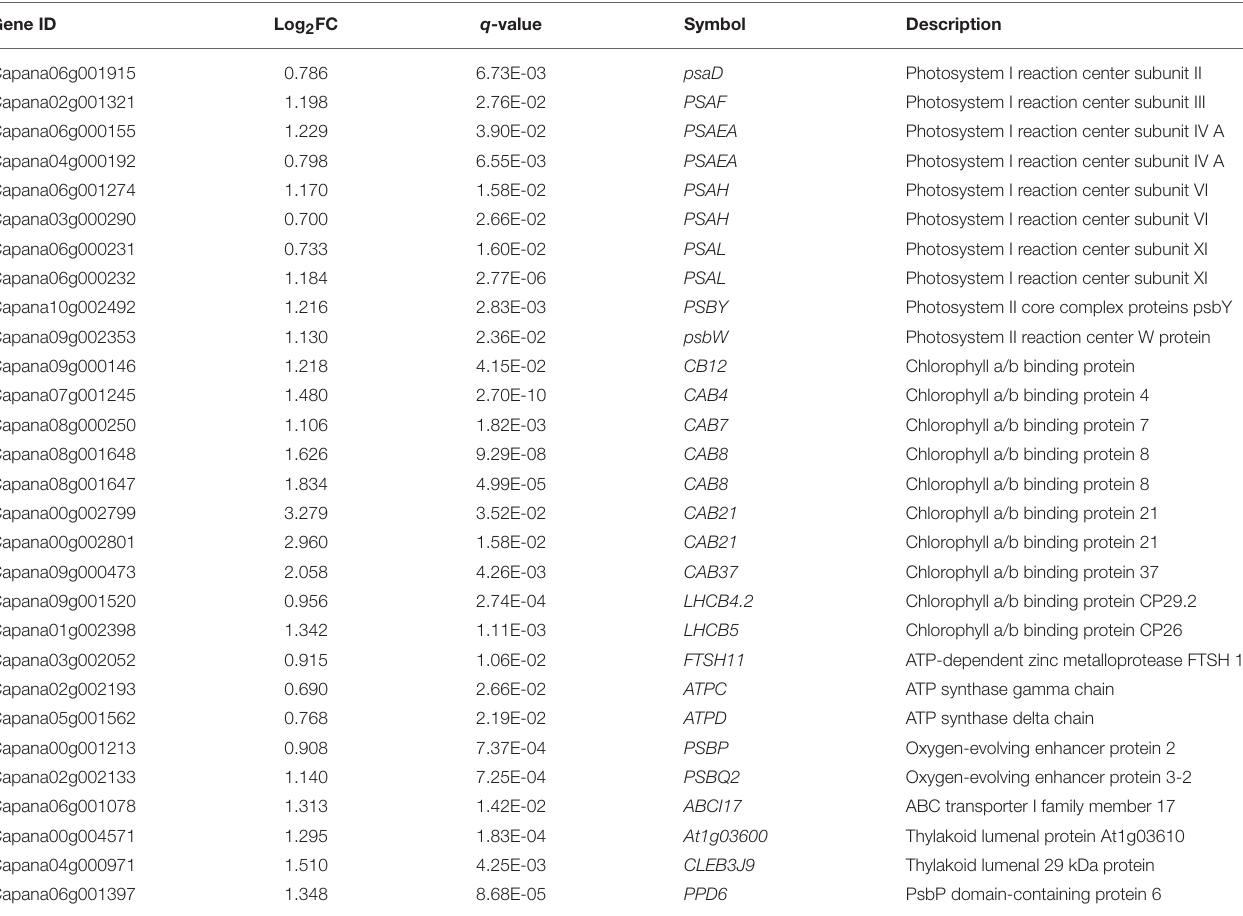
TABLE 4 | Photosynthesis related genes expression in pepper leaves as influenced by chilling alone or in combination EBR treatment. Gene